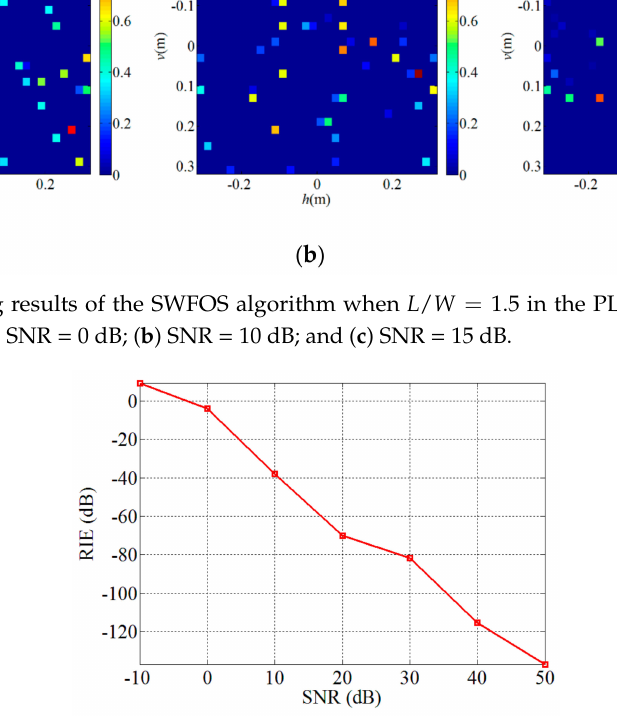
Figure 9. Performance results of the SWFOS algorithm with di ff erent SNRs in the PL-TCAI